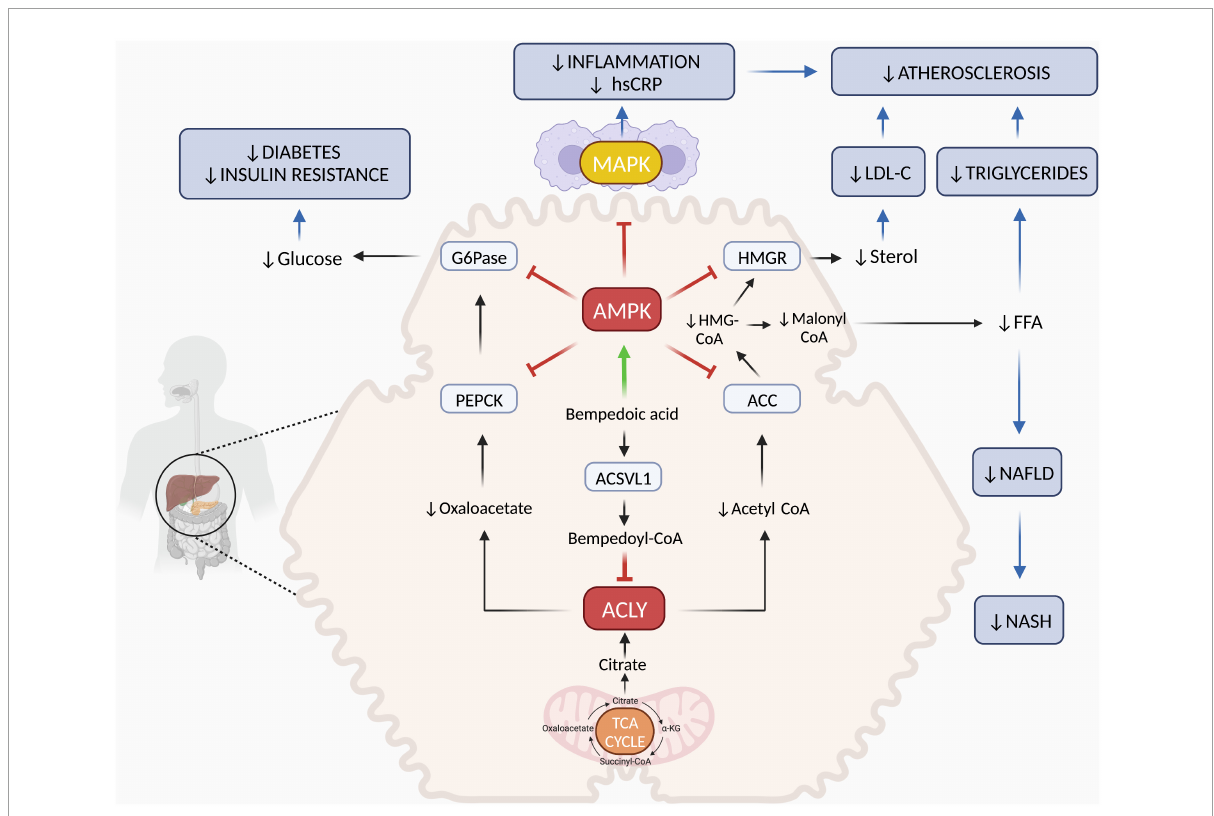
FIGURE1 Mechanisms of action of bempedoic acid. In the cytoplasm of hepatocytes, ACSVL1 converts bempedoic acid to bempedoyl-CoA that directly inhibits ACLY. This is a key enzyme responsible for generating acetyl-CoA and oxaloacetate from citric acid deriving from mitochondrial TCA cycle. Reduction of acetyl-CoA and oxaloacetate levels affects fatty acid and cholesterol synthesis as well as gluconeogenesis. In addition, bempedoic free acid activates the AMPK pathway, which downregulates key rate-limiting enzymes of lipid synthesis (ACC and HMGR) and glucose production (PEPCK and G6Pase). In the liver, the combination of ACLY inhibition and AMPK activation by bempedoic acid decreases cholesterol, FFA and glucose synthesis both by reducing precursor substrates and by downregulating key enzyme activities. Through this mechanism, bempedoic acid may improve dyslipidemia, hepatic steatosis, and diabetes. In skeletal muscle, bempedoic acid cannot be activated to bempedoyl-CoA because ACSVL1 is completely absent in this tissue. Thus, this drug does not promote myotoxicity associated with cholesterol synthesis inhibition, as statins can. In the immune cells and in other tissues, AMPK activation by bempedoic acid downregulates MAPK pro-inflammatory pathways leading to decreased cytokine, chemokine, and adhesion molecule synthesis. Through this mechanism, bempedoic acid decreases inflammation, hsCRP levels and may contribute to atherosclerosis and NASH prevention. Red T indicate inhibition; green arrow indicates activation; blue arrows indicate clinical targets. α -KG, α -ketoglutarate; ACLY, ATP-citrate lyase; ACSVL1, very long-chain acyl-CoA synthetase-1; AMPK, AMP-activated protein kinase; ACC, acetyl-CoA carboxylase; HMGCoA, 3-hydroxy-3-methylglutaryl coenzyme A; HMGR, 3-hydroxy-3-methylglutaryl-CoA reductase; G6Pase, glucose-6-phosphatase; PEPCK, phosphoenolpyruvate carboxykinase; TCA, tricarboxylic acid; FFA, free fatty acids; NAFLD, non-alcoholic fatty liver disease; NASH, non-alcoholic steatohepatitis; MAPK, mitogen-activated protein kinase; hsCRP, high-sensitivity C-reactive protein. Figure was created with